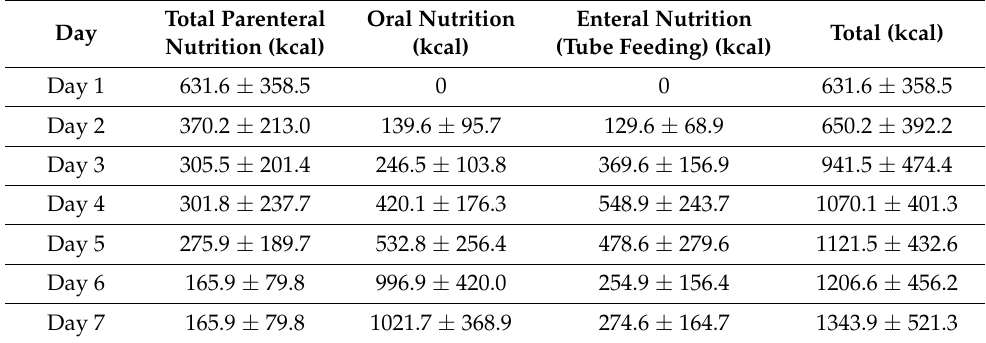
Table 6. Average postoperative (D1–D7) dietary intake according to energy source (parenteral, enteral, oral).